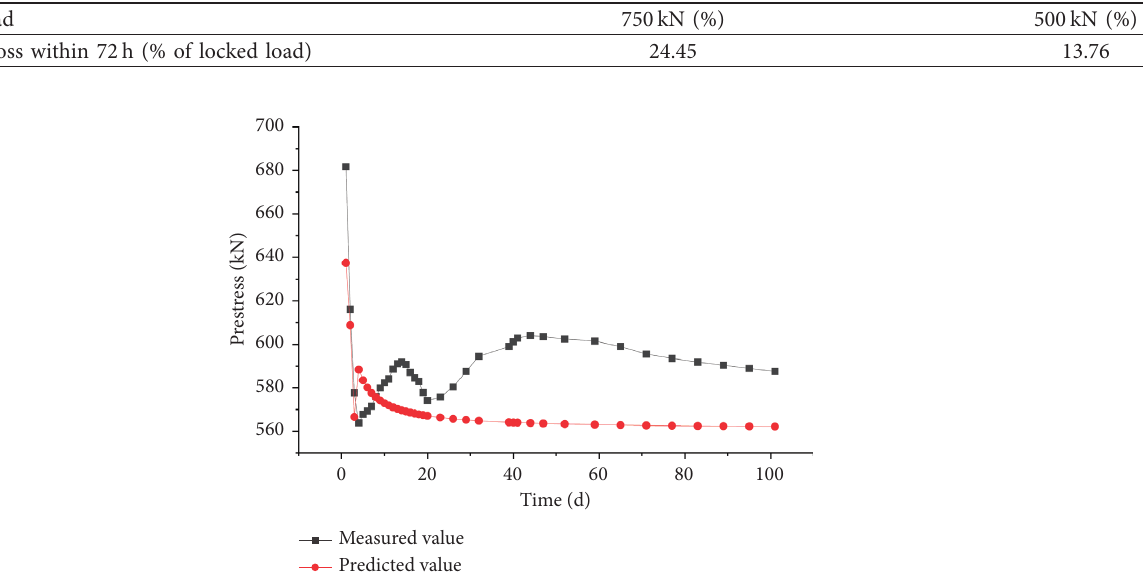
Figure 8: Comparison of measured data with improved model prediction data for the first row of 750kN anchor cables at K5 +420.